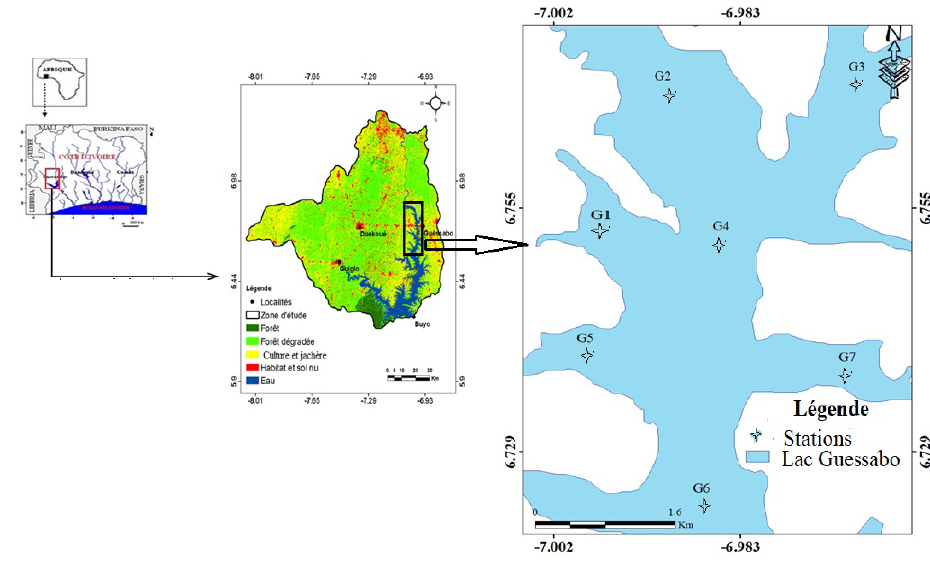
Figure 1. Stations d’échantillonnage et localisation de la zone